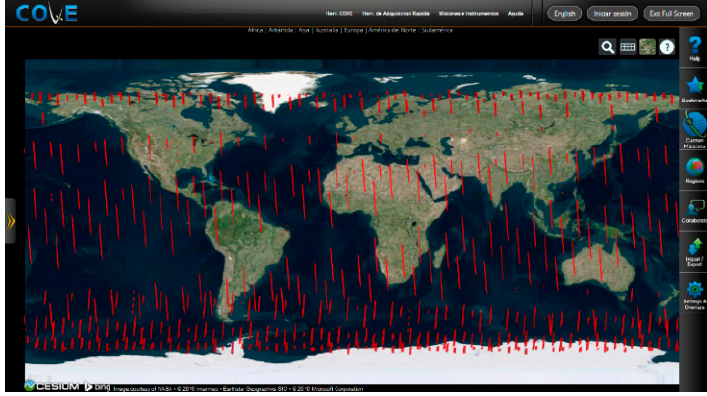
Figure 2. Multi-Spectral Imager (MSI) of Sentinel 2 and TRUTHS simulated overpasses for a one-year period with time interval of 30 min at nadir.